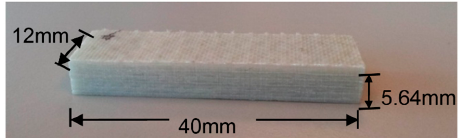
Figure 1. Fiber-reinforced polymer (FRP) laminate short beam specimen.